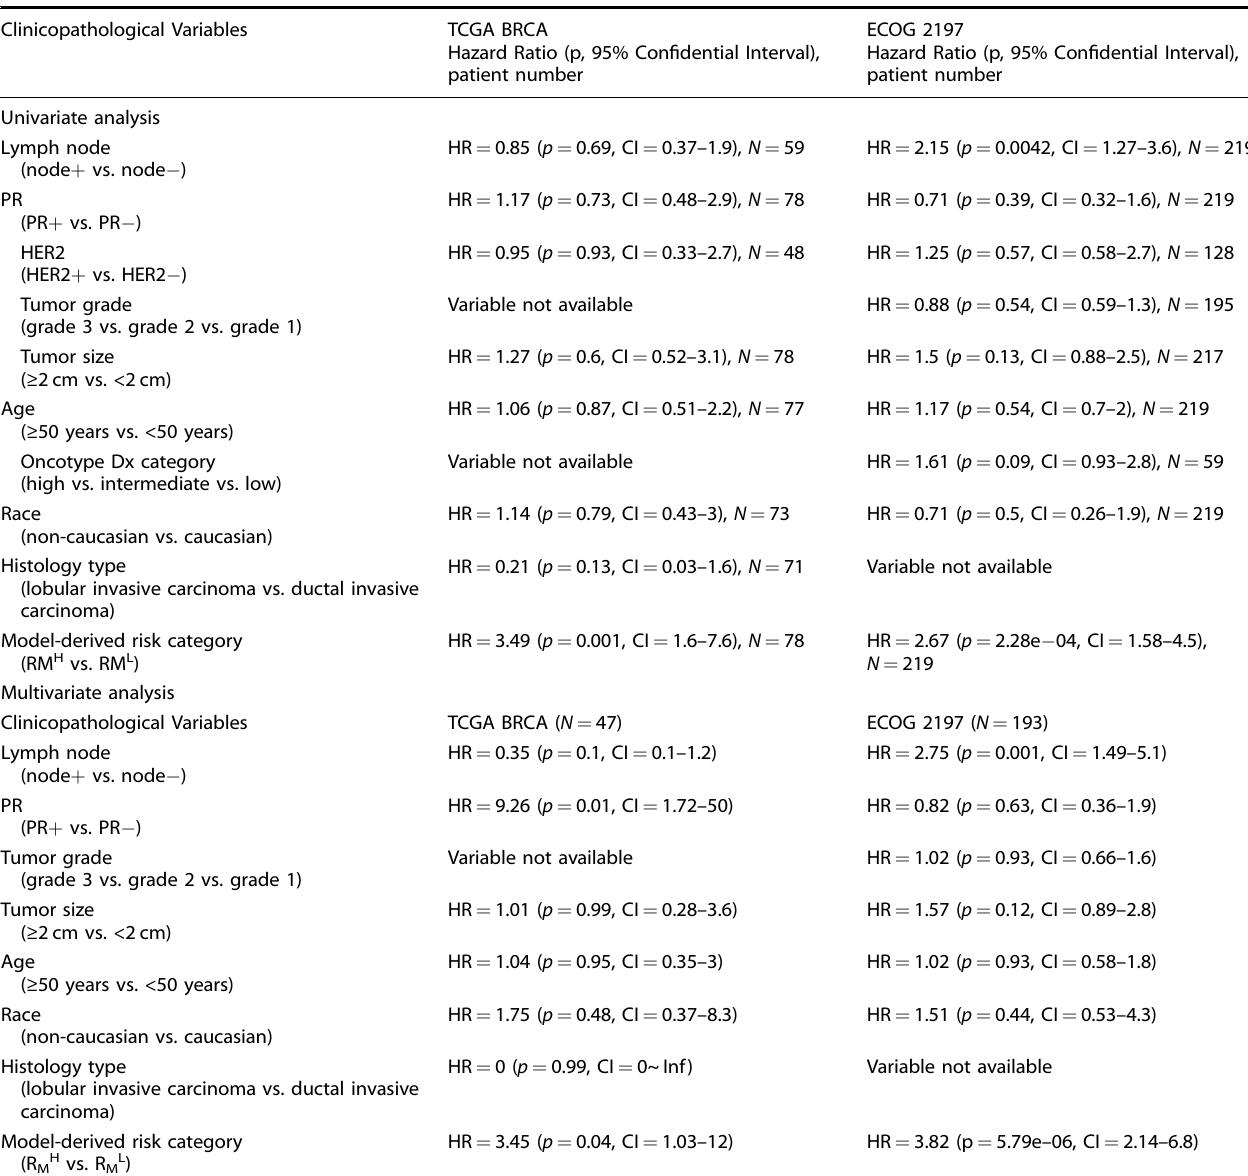
Table 2. Univariate and Multivariate Cox proportional hazards analysis for DFS on R M /clinicopathological variables/Odx risk category on S t and S t . Clinicopathological